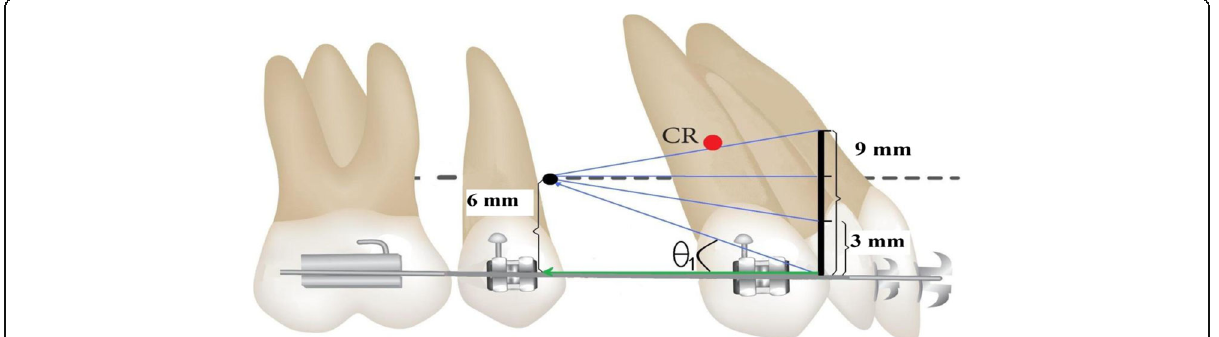
Fig. 3 Schematic force diagram and θ 1 angle in the mesial placement of the mini screw